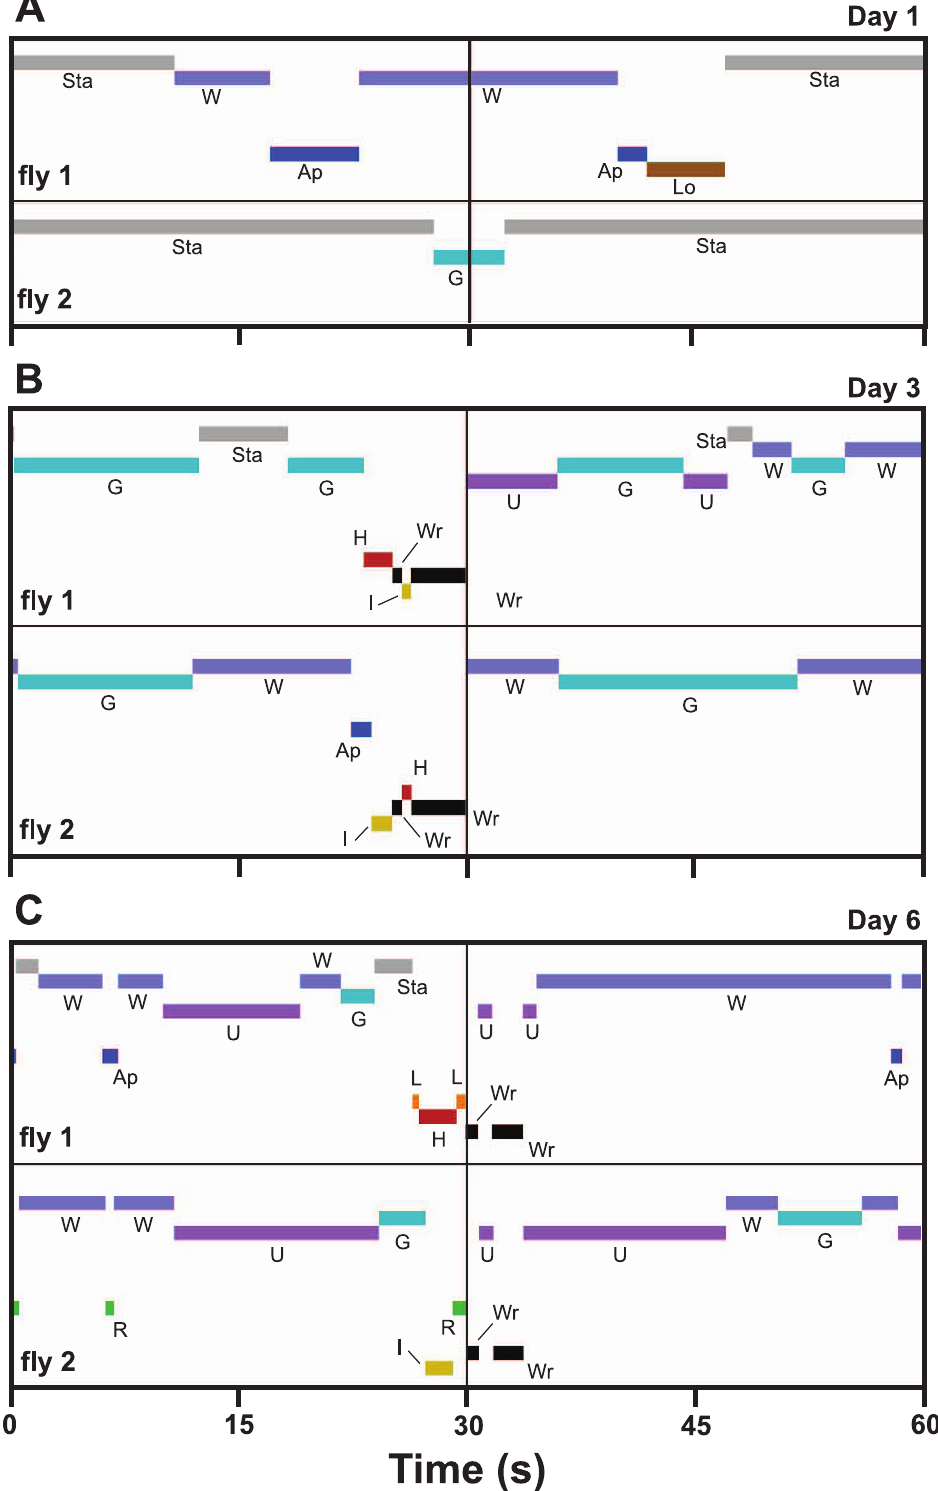
Figure 3. Examples of behavioral sequences and interactions observed in the experimental arena. Each plot encompasses 1 min of observation and depicts the simultaneous activity of both members of the pair. The time of occurrence of the observed behaviors, represented as horizontal bars, are color-coded and also labeled (using the abbreviations in Table 1). Pairs of male flesh flies were selected from the day 1 (A), day 3 (B), and day 6 (C) age cohorts.